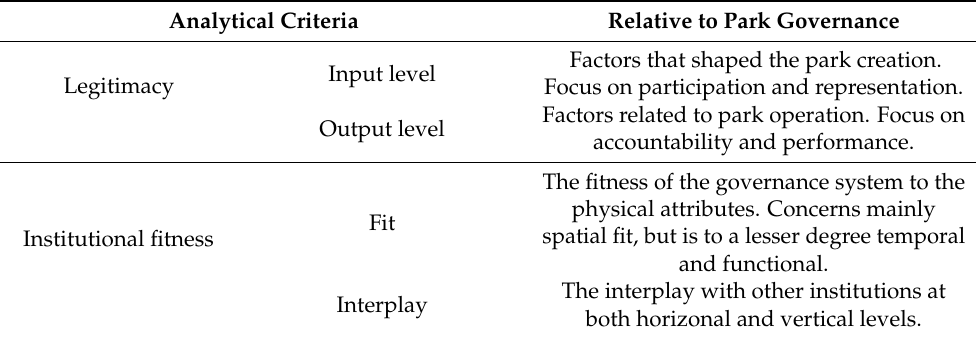
Table 1. Criteria for the co-management governance system performance assessment. Analytical Criteria Relative to Park Governance